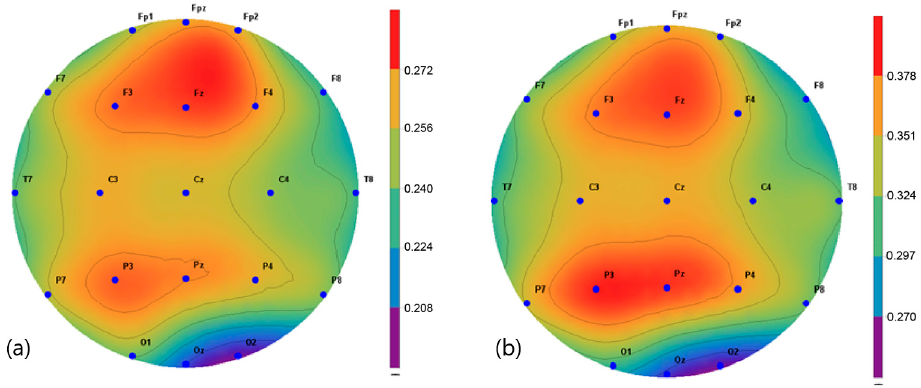
Figure 5. Mapping of the alpha power value ( a ) before and ( b ) after training in the virtual reality- based bilateral arm training group.